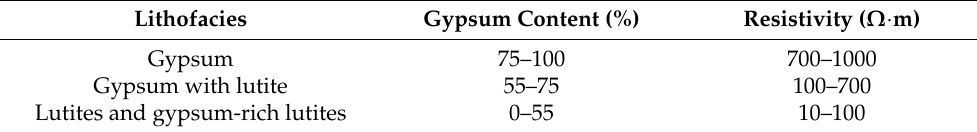
Table 2. Geoelectrical classification of gypsum rocks (modified after Guinea et al., 2010b,